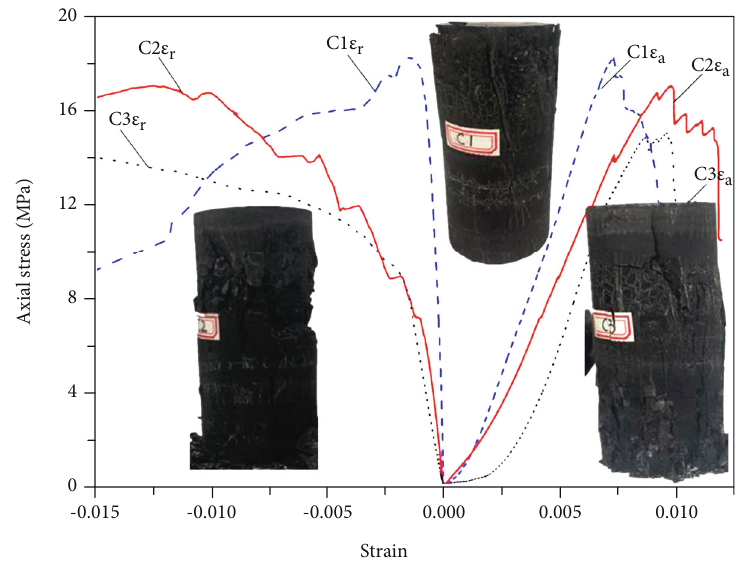
Figure 2: Stress-strain curves of coal in uniaxial compressive tests.